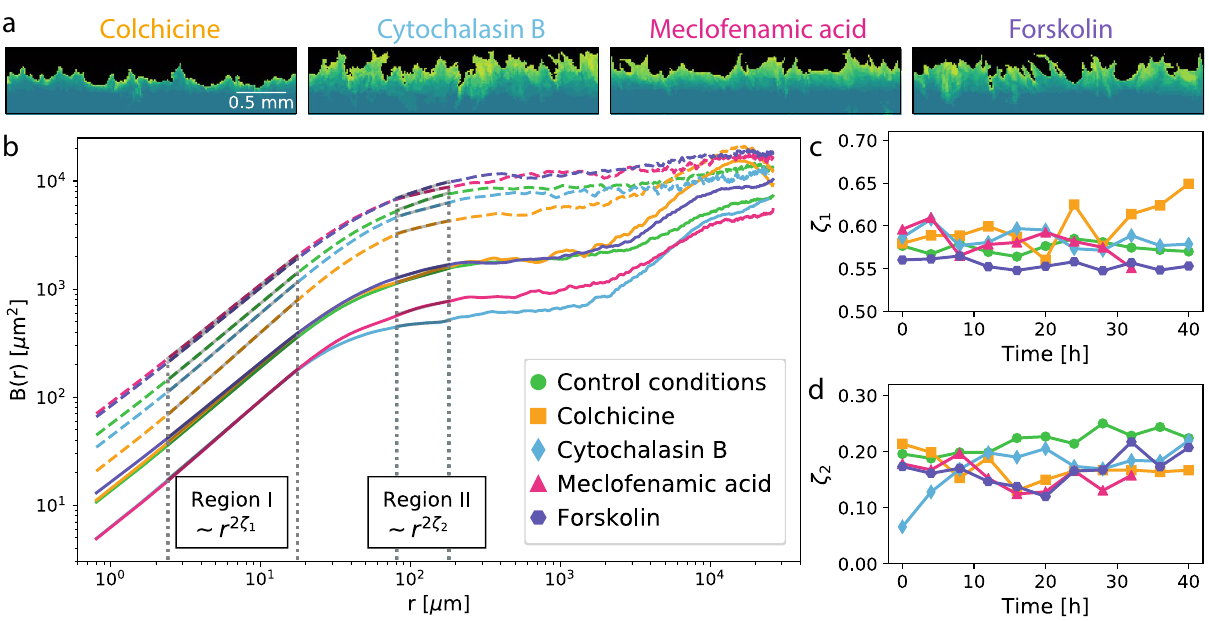
Figure 2. Proliferating Rat1 fibroblast cell fronts after pharmacological modulation. ( a ) Superposition of successive fluorescence microscopy images taken over 40 h, with earlier front pictured in dark green and more recent ones in lighter green. ( b ) Cell front roughness B ( r ) at 0 and 24 hfor the four different inhibitors, showing again two distinct power-law scaling regions. ( c , d ) Roughness exponents ζ as a function of time for cell fronts under control conditions (green) and after exposure to cytochalasin-B (blue), colchicine (orange), meclofenamic acid (magenta), and forskolin (purple) at sub-cell lengthcales ( c , ζ 1 ) and few-cell lengthscales ( d , ζ 2